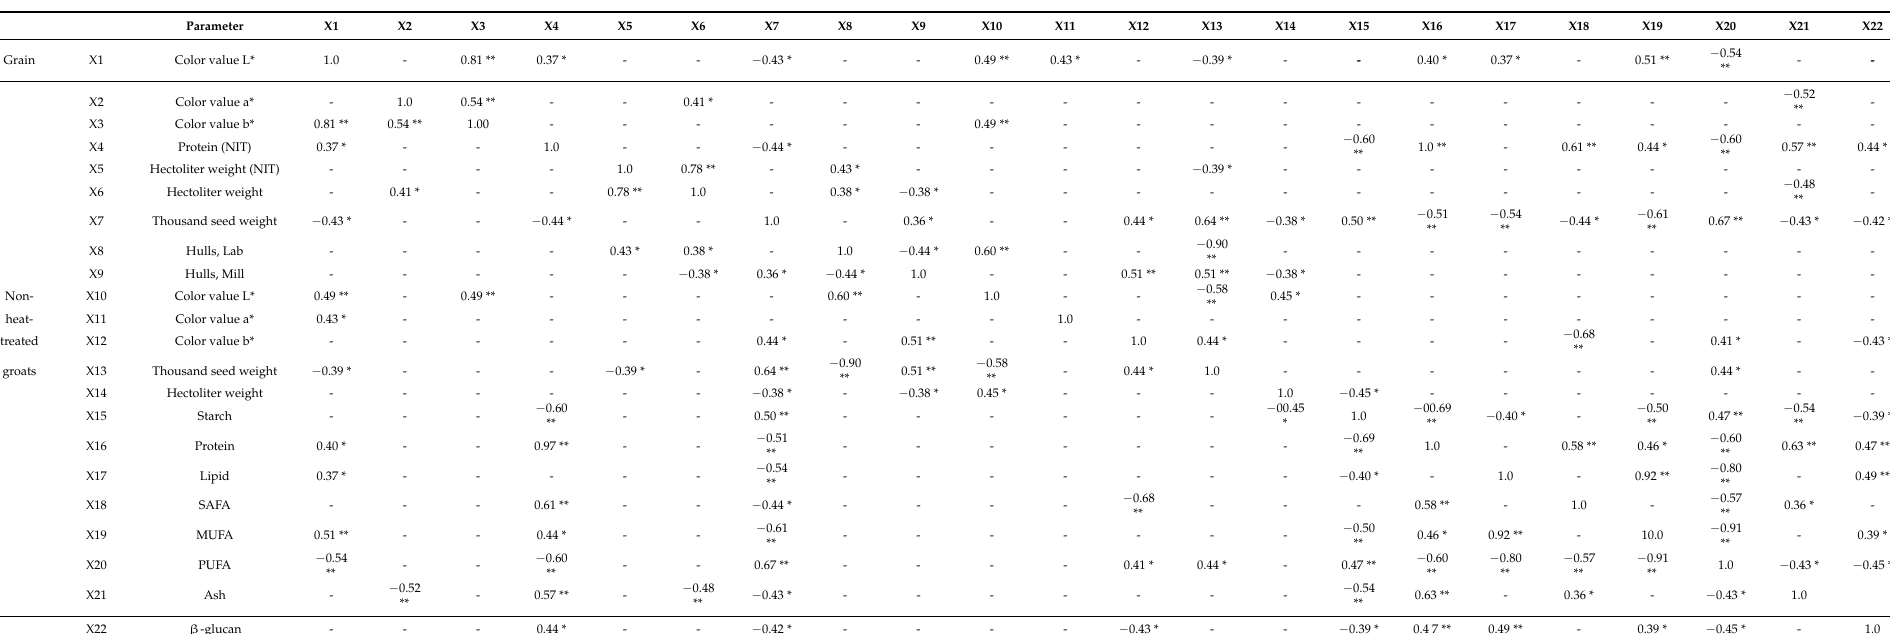
Table A6. Pearson correlation coefficients of 30 native oat grain and non-heated flour properties. The color values are L*, a* and b*. NIT, near-infrared transmittance; SAFA, saturated fatty acids; MUFA, monounsaturated fatty acids; PUFA, polyunsaturated fatty acids. Parameter